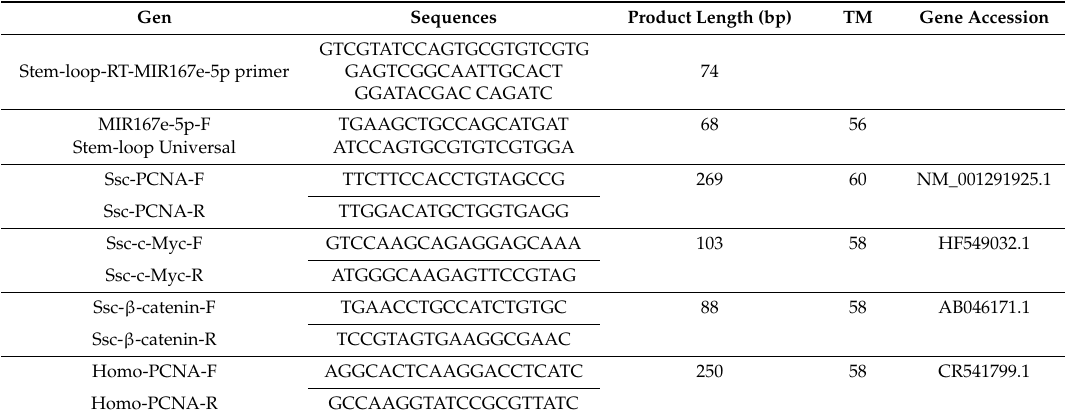
Table 1. qPCR and PCR